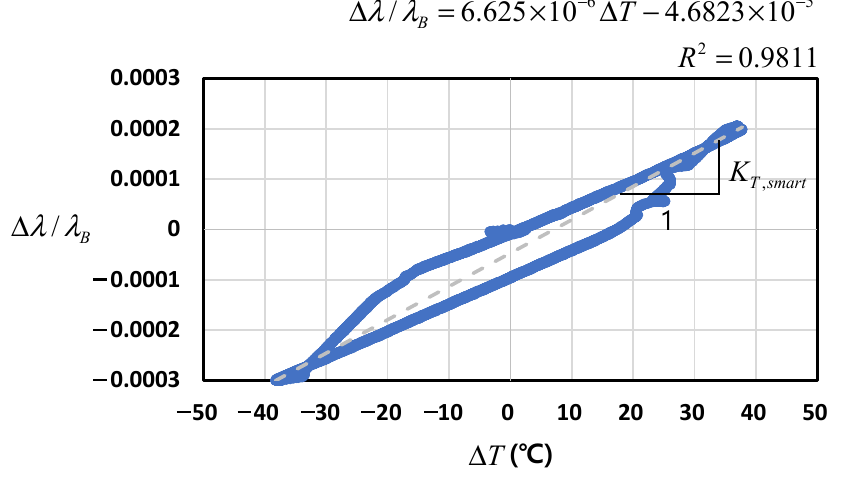
Figure 8. Wavelength–temperature relation of Smart Strand.